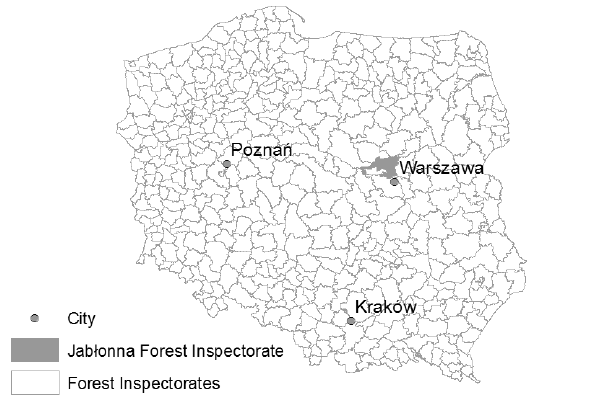
Figure 2. Location of the study area.